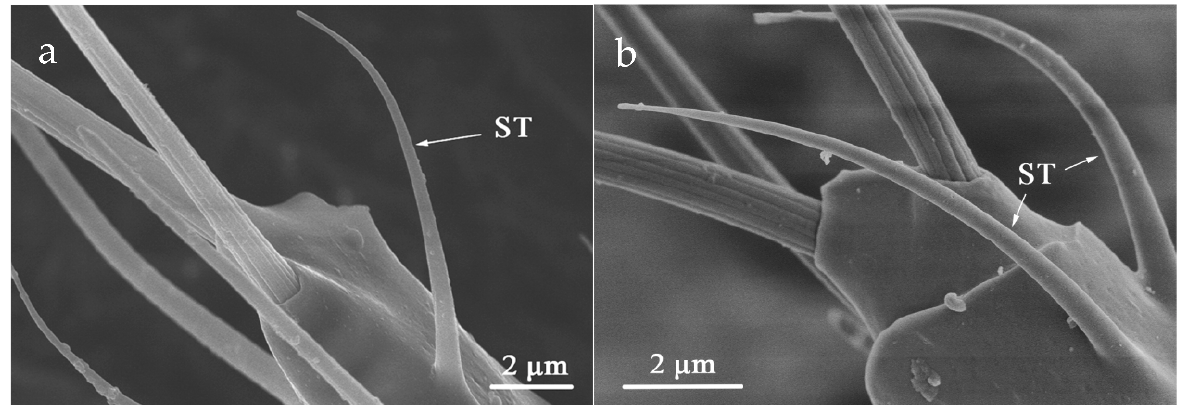
Figure 11. Sensilla trichodea (ST) at the flagellum VI. ( a ) O. loti . ( b ) S. kaszabi